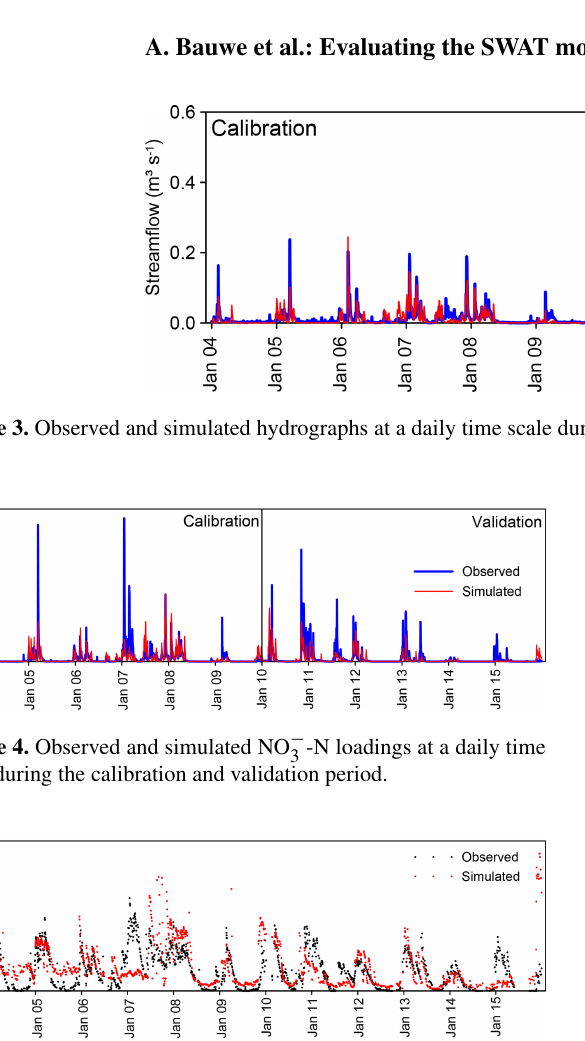
-N concentrations at a daily 3